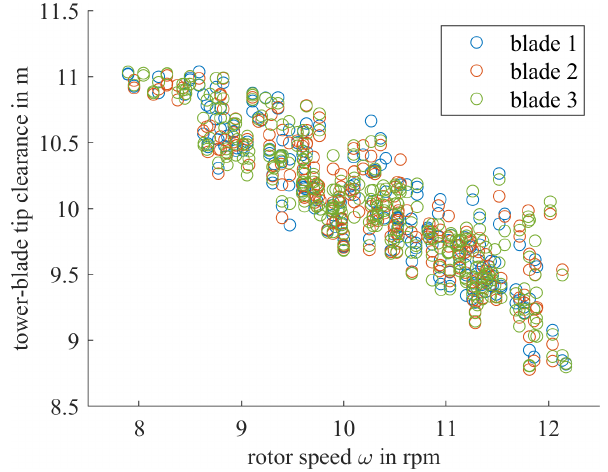
Figure 15. Tower–blade tip clearance over rotor speed ω with a laser scanner system for different blades (blade 1 in blue, blade 2 in orange and blade 3 in